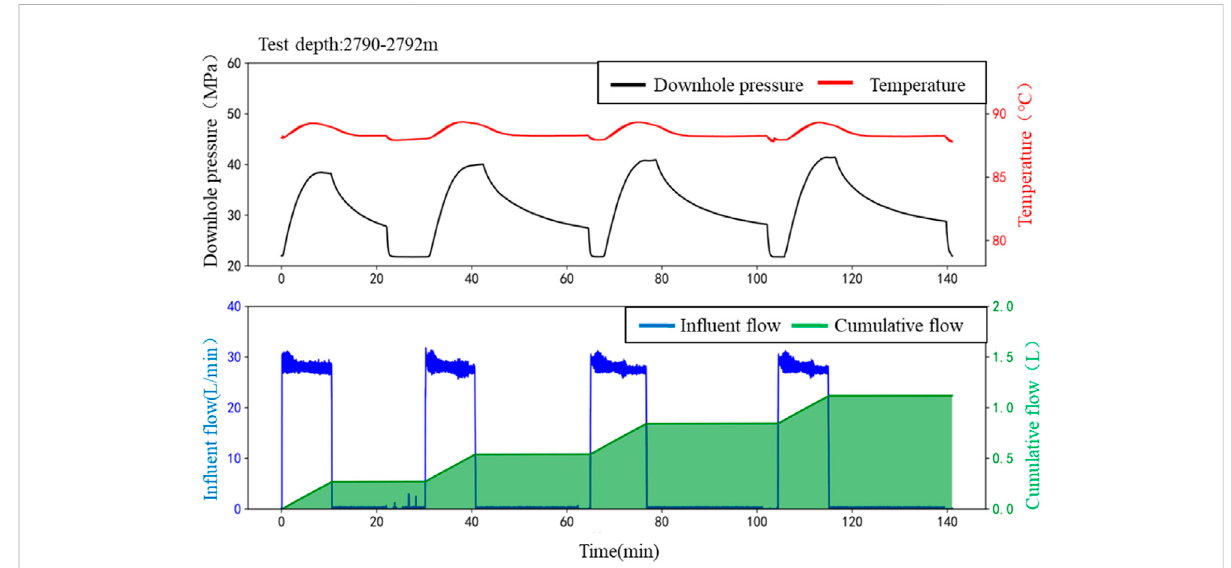
FIGURE 2 Downhole pressure – time and surface fl ow and cumulative fl ow